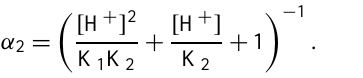
of the experiment. In the NBp treatment inoculated with S.